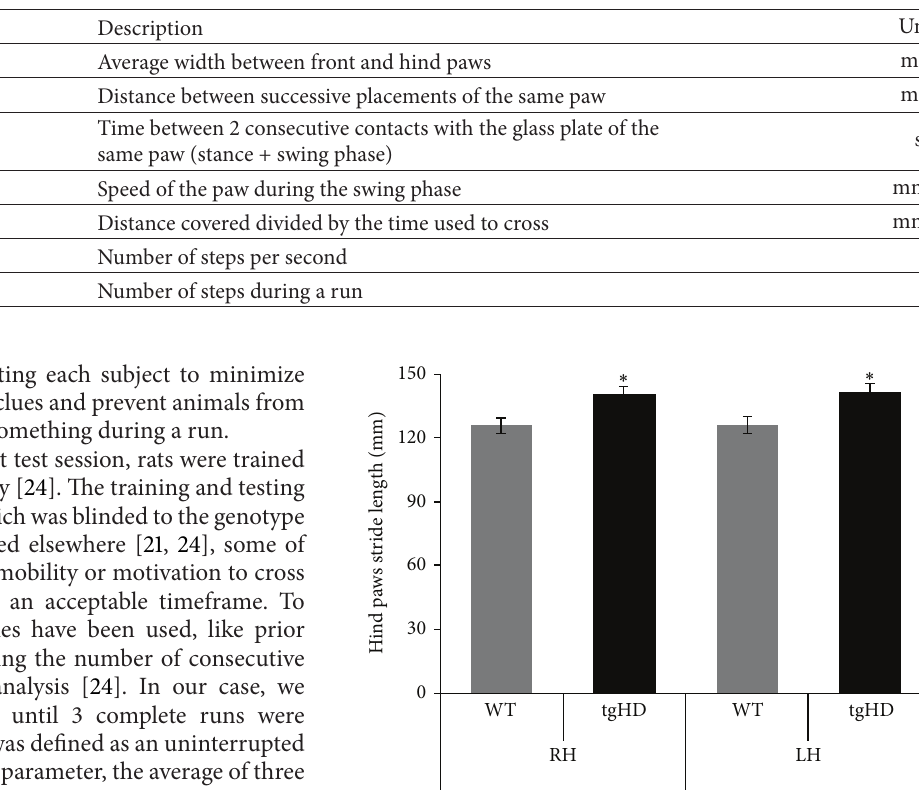
Table 1: Description of the parameters selected and analyzed from the Catwalk test and respective units of measure.